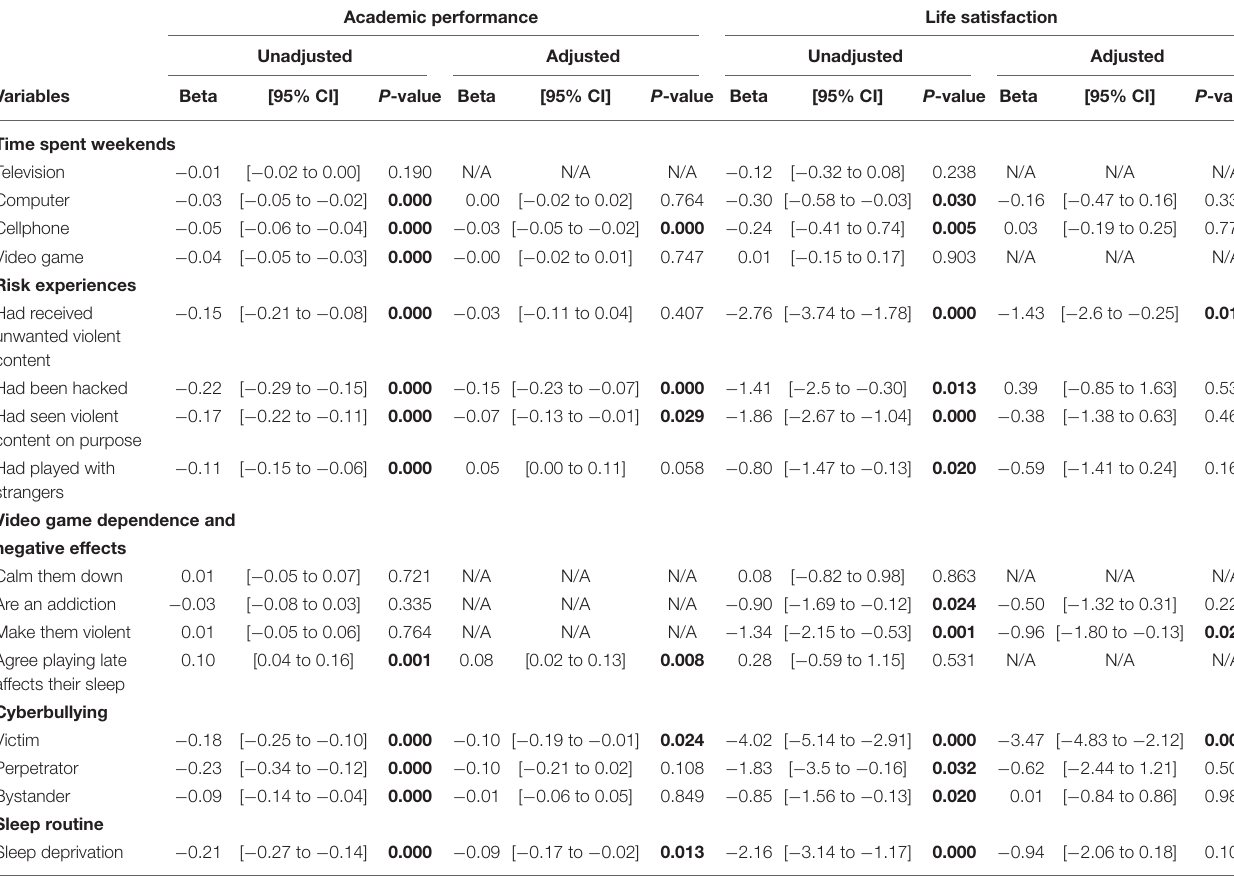
TABLE 9 | Associations between time spent using technological devices during weekends and academic performance and life satisfaction.